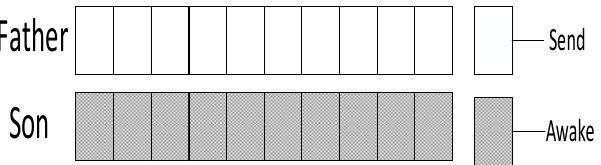
Figure 12. Example of slots when transmission is the minimum ( m = 10).